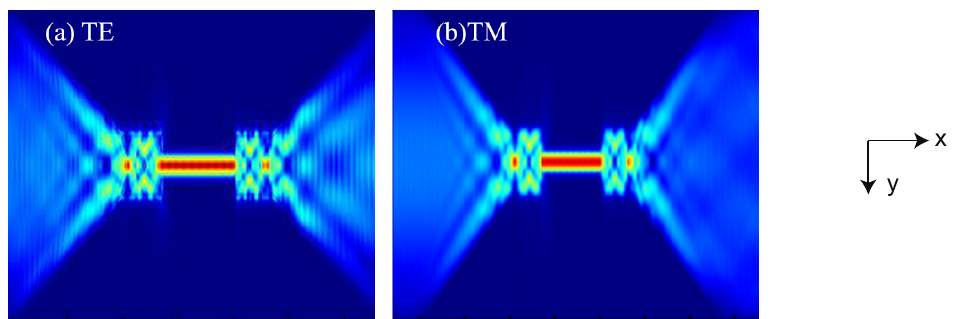
Figure 5. Energy distribution for both TE and TM polarizations with two output tapers being joined in opposite directions.